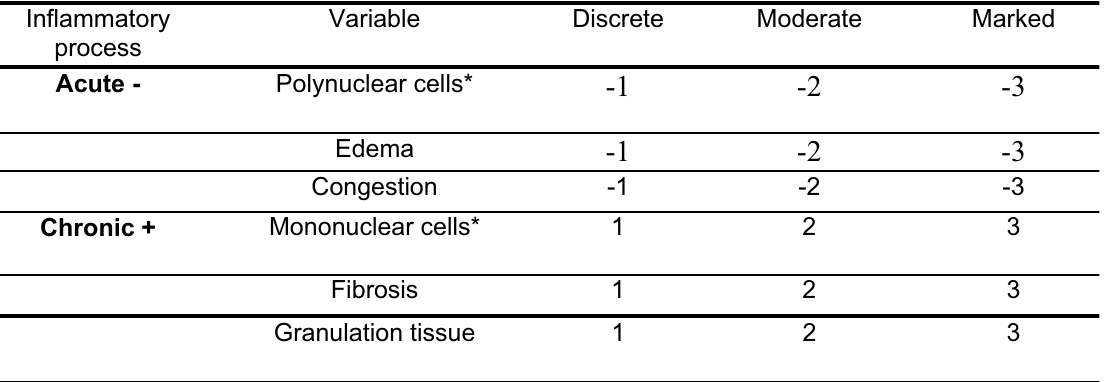
TABLE 1 - Variables used to establish the final inflammation score